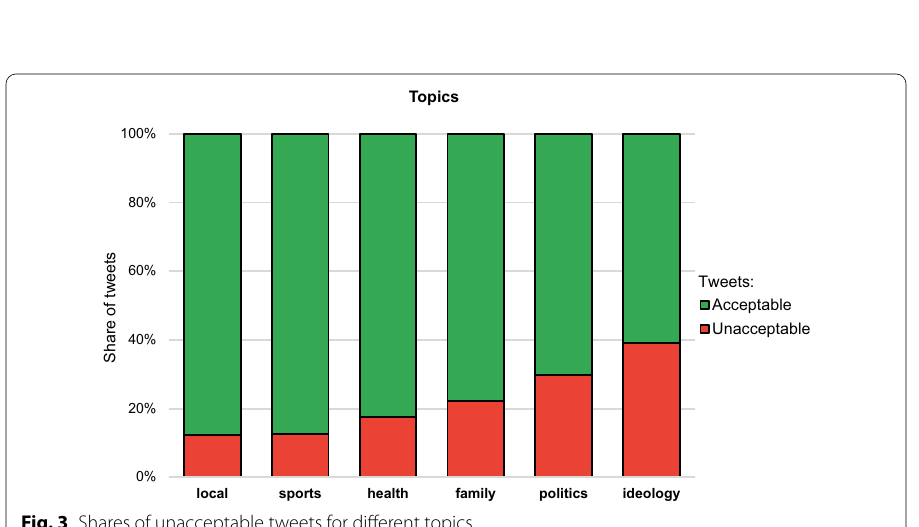
Fig. 3 Shares of unacceptable tweets for different